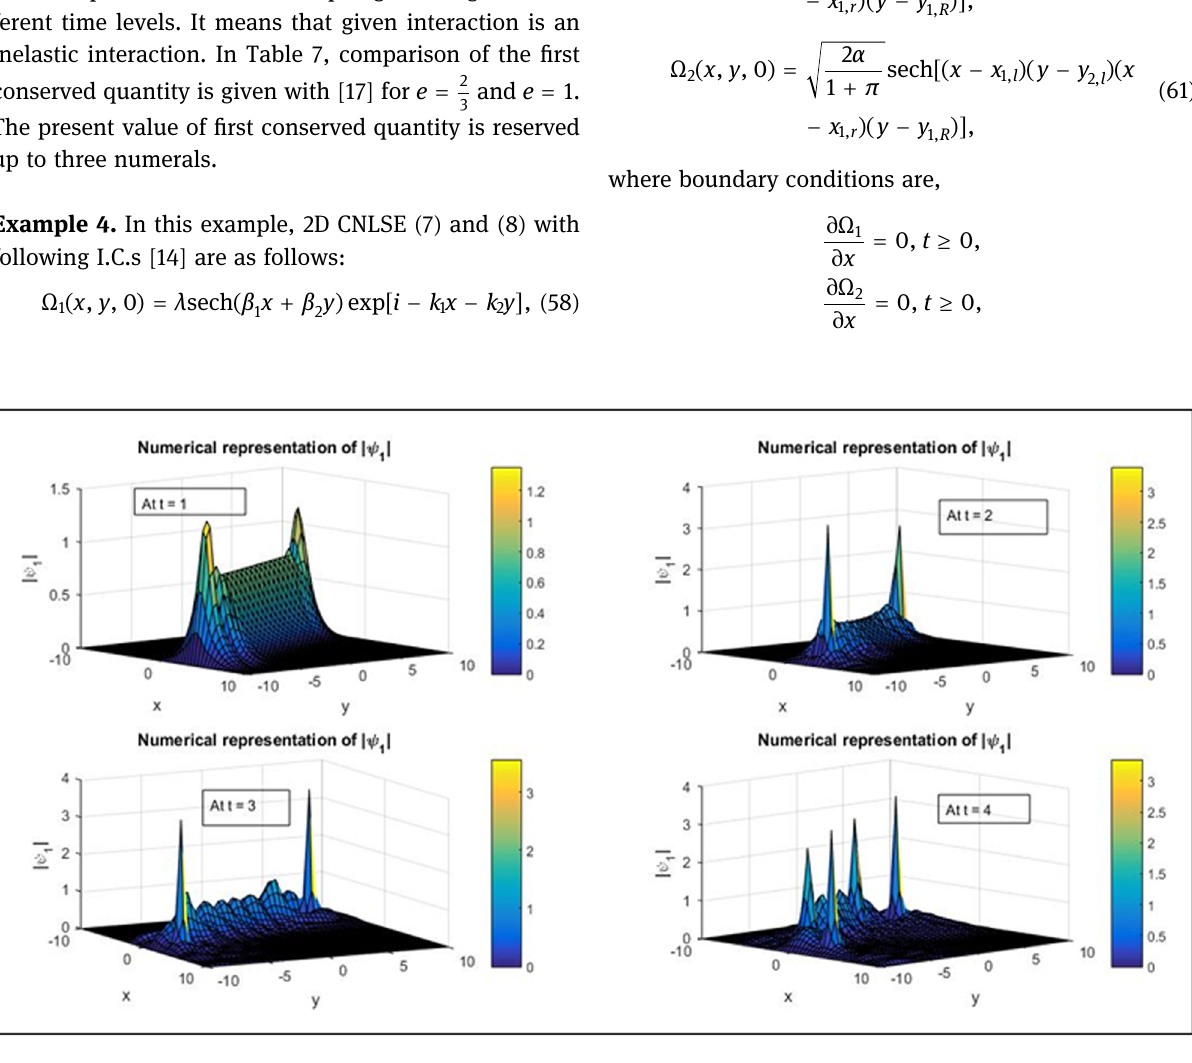
Figure 13: Representation of numerical solution of fi rst - wave amplitude with = N 51 , at = t 1 , 2, 3, and 4, = τ 1 [ −10, 10 ]